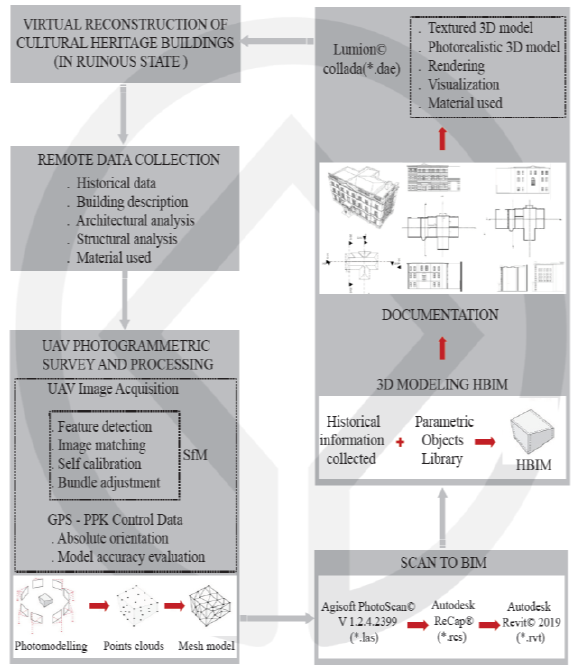
Fig. 6. Modeling procedure